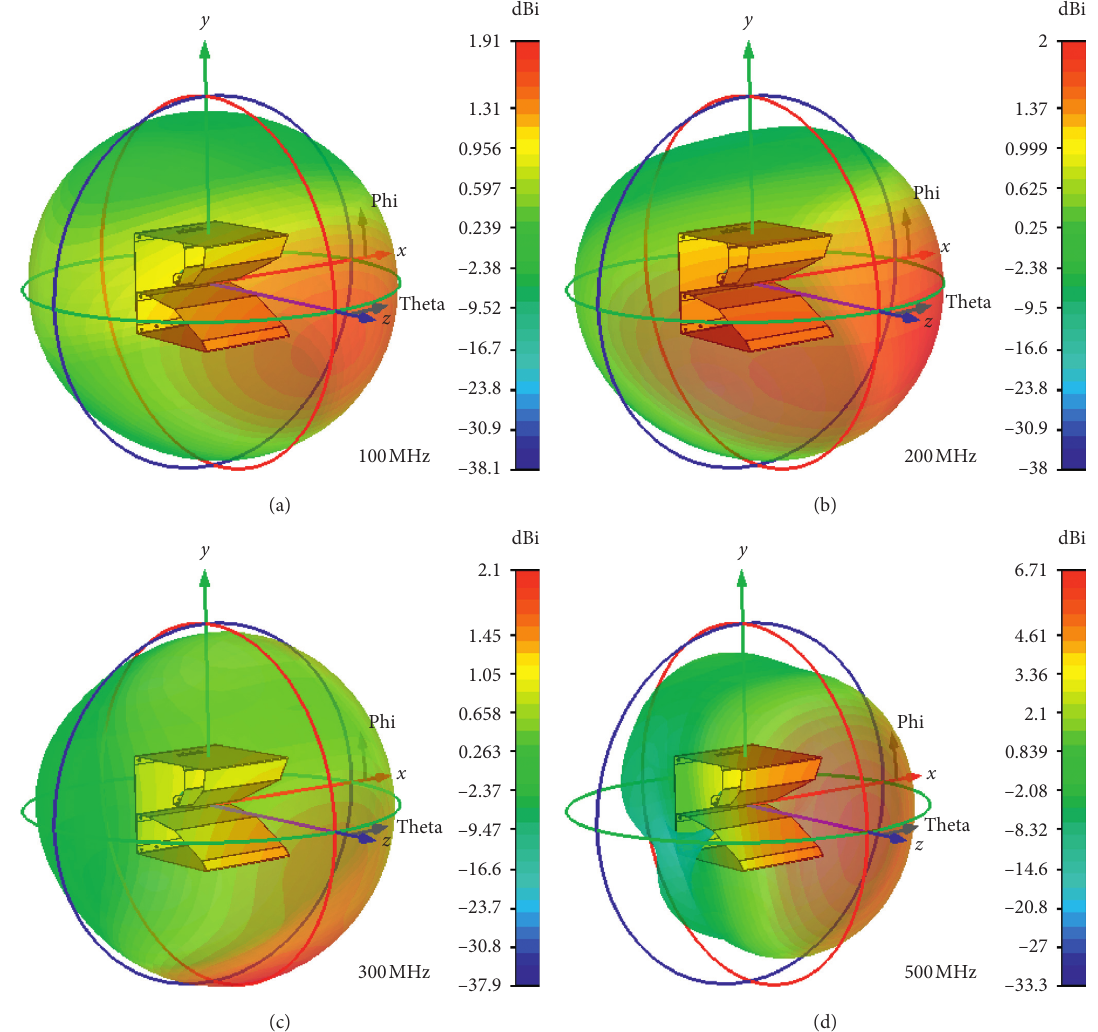
Figure 4: 3D antenna pattern at different